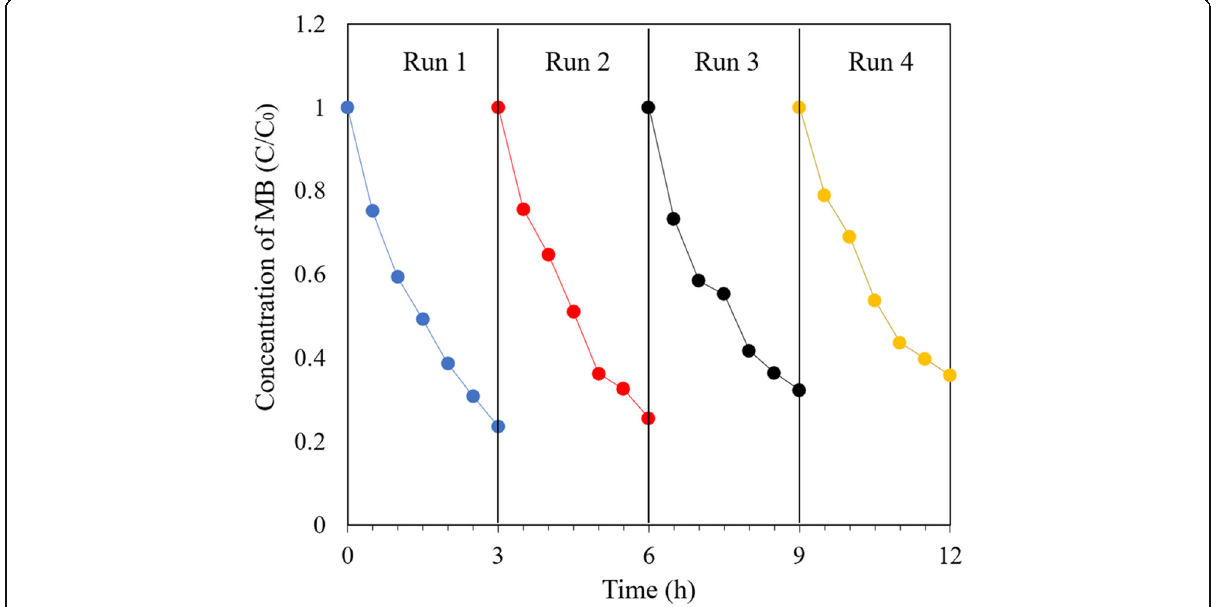
Fig. 9 Stability test of CNTs/CF M electrode via the repeating experiment of electrochemical degradation of MB by using CNTs/CF M as both cathode and anode under an applied current of 50 mA and electrolyte of 0.1 M H 2 SO 4 (initial pH value of 1.83). Initial MB concentration of 10 mg L −